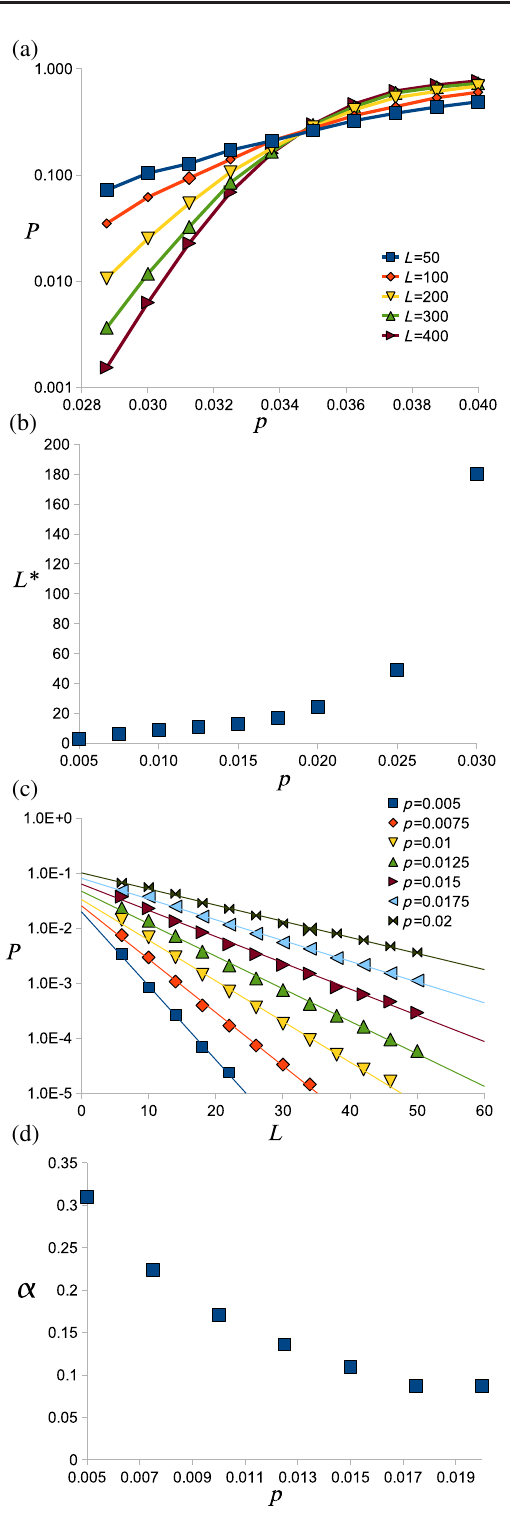
FIG. 3. (a) Graph of logical error rate P against error rates p around threshold. (b) Graph of minimum linear system size required for error correction to become evident, L (cid:2) , against p . (c) Graph of P against linear system size L for various p well below threshold. Fittings to an exponential of the form P ¼ ce − α L are shown. (d) A graph of α against p calculated using this